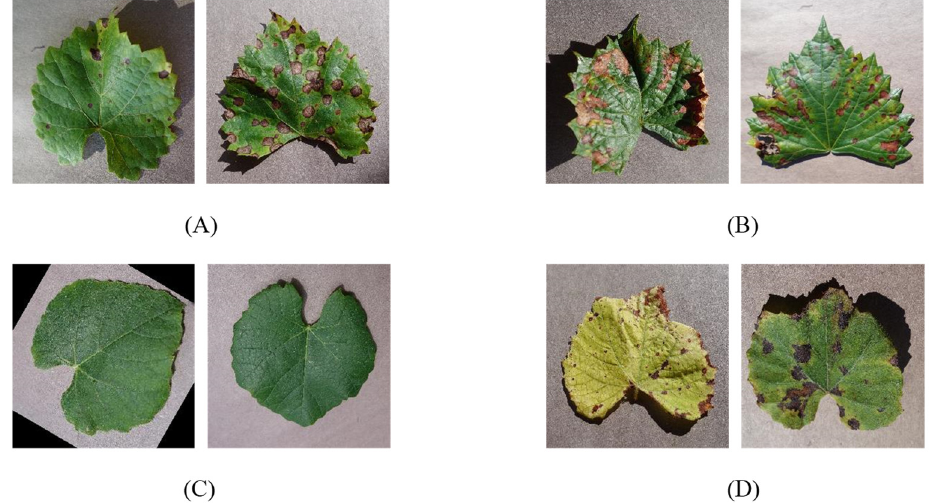
Figure 2. Few samples grape leaf image dataset. ( A ) Black rot leaf image; ( B ) Black_measles leaf image; ( C ) Healthy leaf image; ( D ) Leaf_blight leaf image.